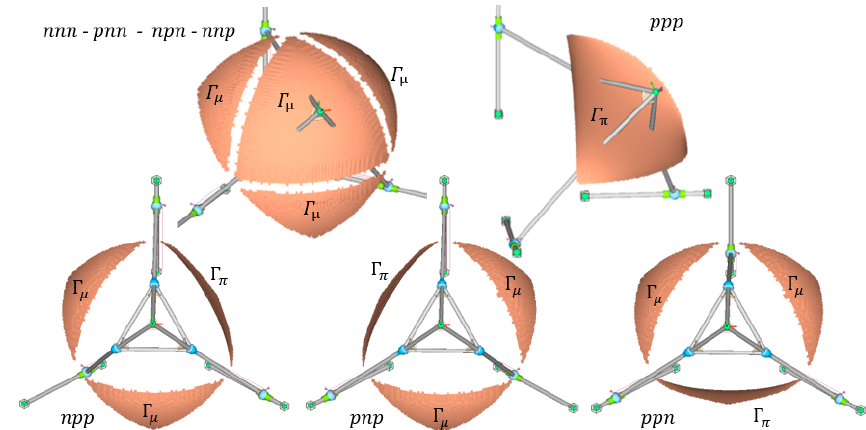
Figure 18. Specific direct singularities for the different working modes in the workspace.